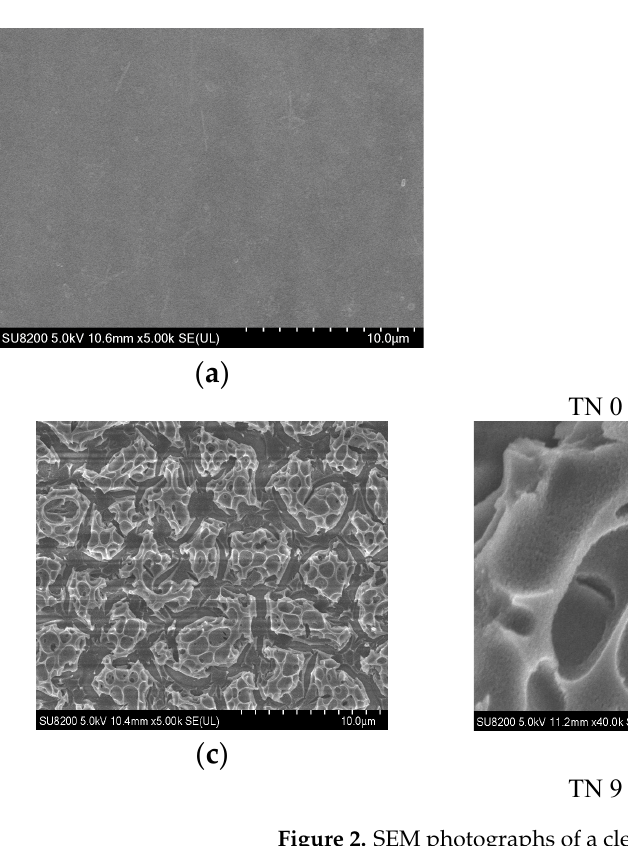
Figure 2. SEM photographs of a clean glass substrate ( a , b ) (TN0) and SEM photographs of sample TN9 ( c – e ).